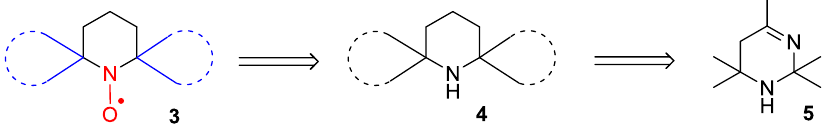
Figure 3. The retrosynthetic scheme for obtaining piperidine-type SNRs 3 from acetonine 5 through intermediate cyclic amine 4 .